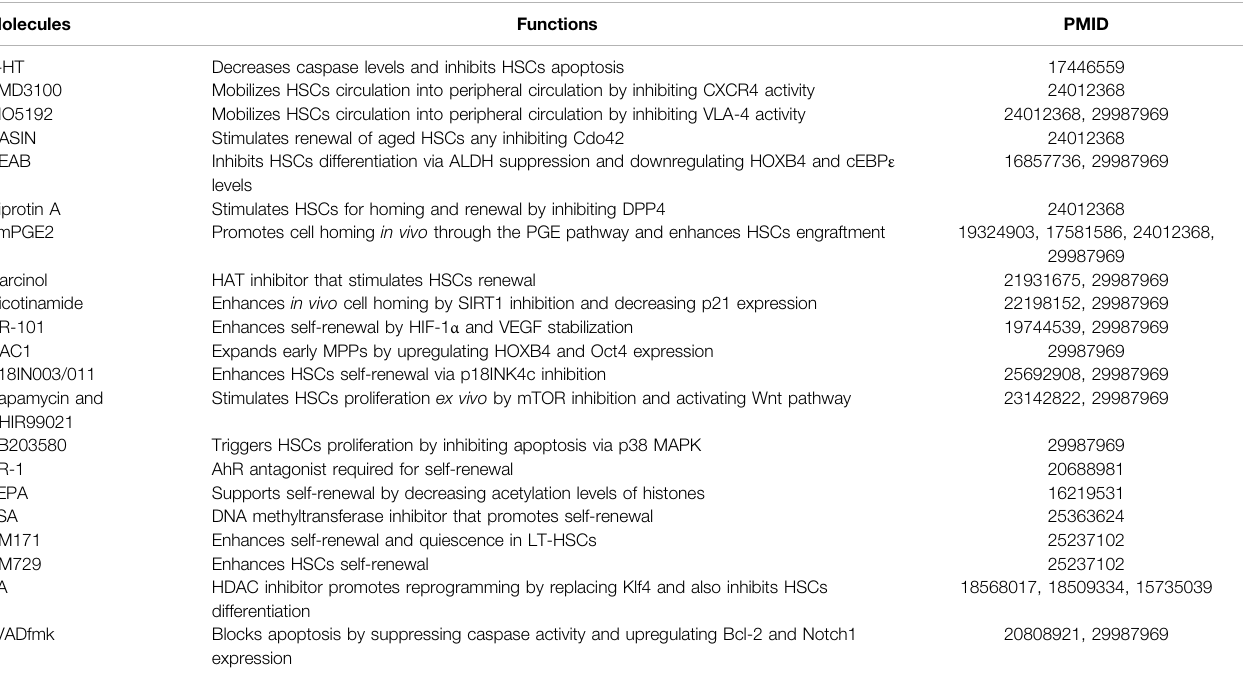
TABLE 3 | Chemical molecules used in ex vivo HSCs expansion.